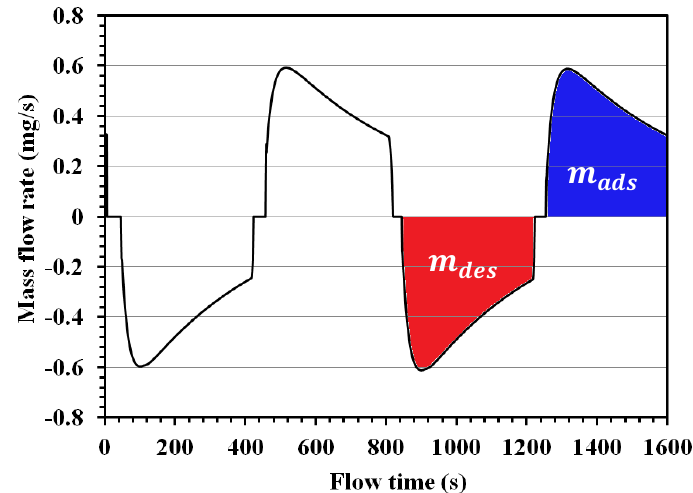
Figure 10. Simulated inlet/outlet mass flow rate to and from the adsorber for a volume between 2 fins.